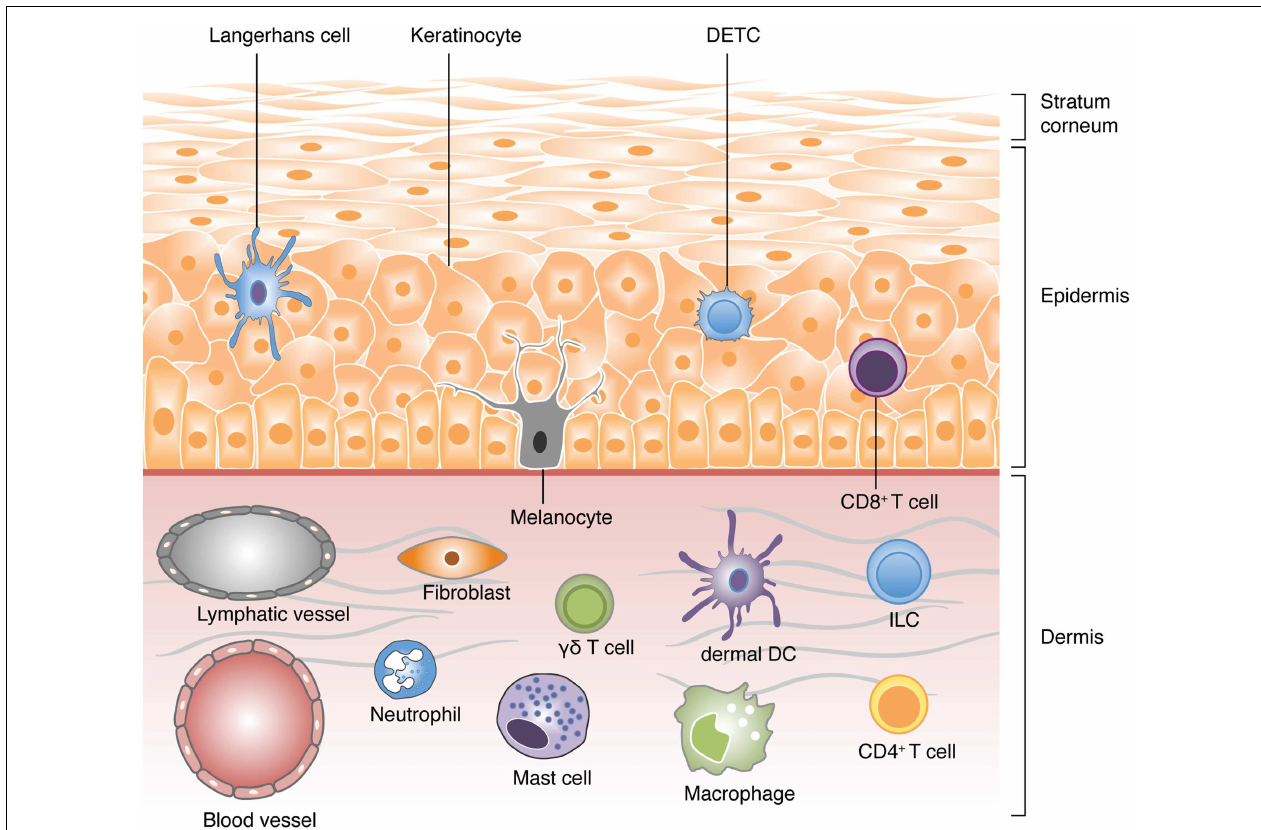
compartment include Langerhans cells (LCs), dendritic epidermalT-cells (DETC; a subset of γδ T-cells), and CD8T-cells.The dermis is a highly vascularized region, rich in collagen, and elastin fibers, with low cell density. It comprises of fibroblasts,T-cells (CD4 αβ , and γδ ), innate lymphoid cells (ILCs), dermal DCs (dDCs), macrophages, mast cells, and neutrophils (non-exhaustive